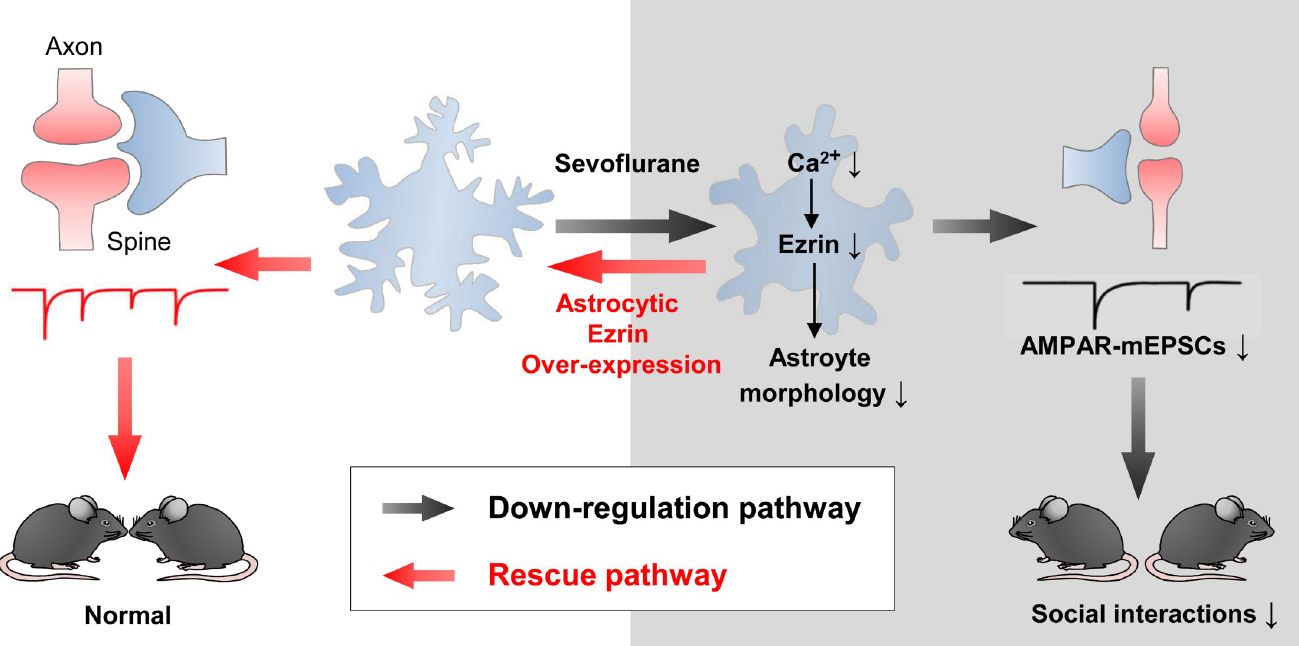
Fig 7. Summary for the key findings in the current study. Lengthy Sevo exposure disrupted astrocyte intracellular Ca 2+ signals, which led to the down-regulation of Ezrin. The loss of Ezrin resulted in astrocyte morphological deficits, producing aberrant synaptic structure and function, which contributed to the deficits in social behaviors. Overexpression of astrocyte Ezrin not only rescued astrocytic and neuronal dysfunctions but also fully corrected deficits in social behaviors in Sevo group mice. AMPAR, α -amino-3-hydroxy-5-methyl-4-isoxazole propionate receptor; mEPSCs, miniature EPSCs; Sevo, sevoflurane.